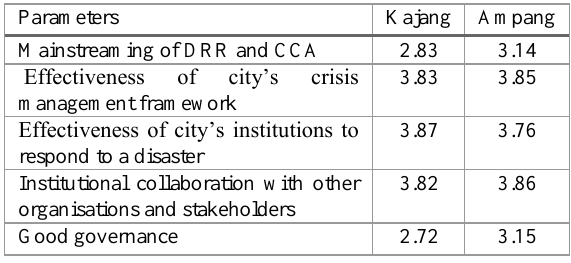
Table 6: Assessment of Institutional Component. Source: